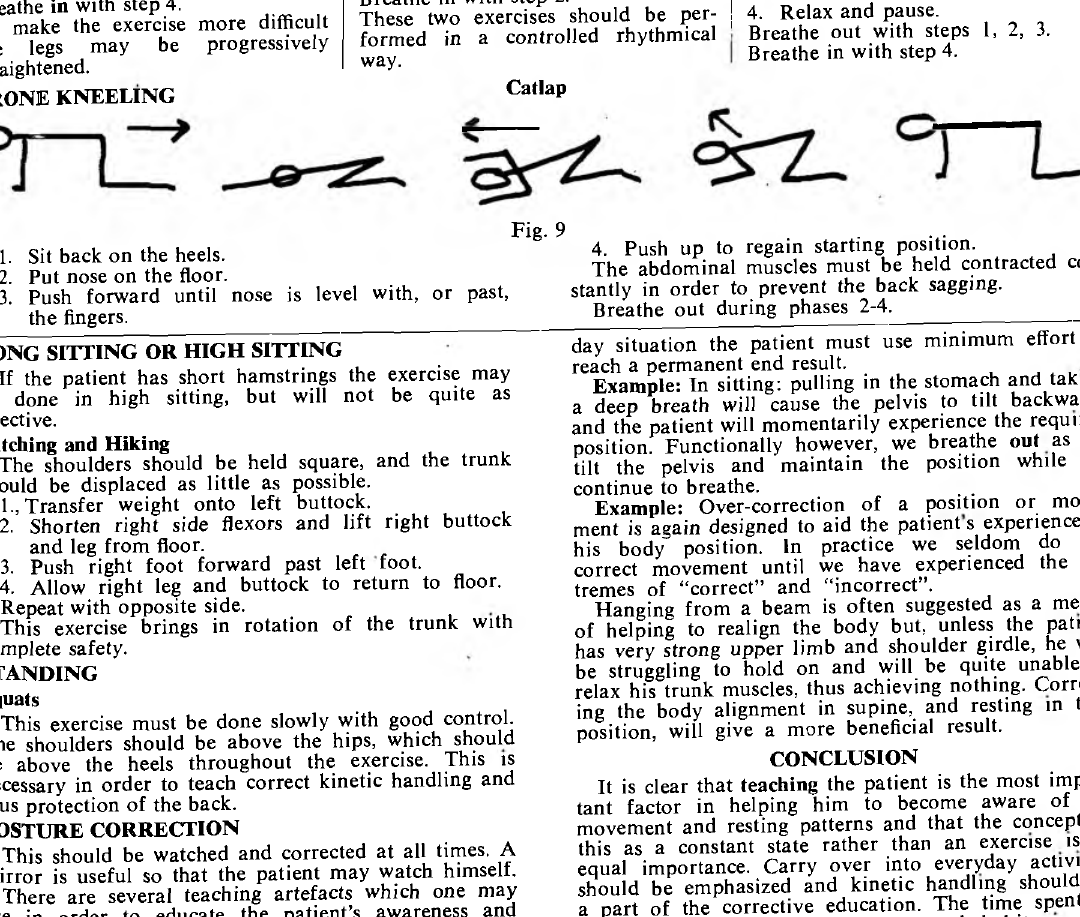
Lie relaxed with arms resting on table or holding sides of the table.